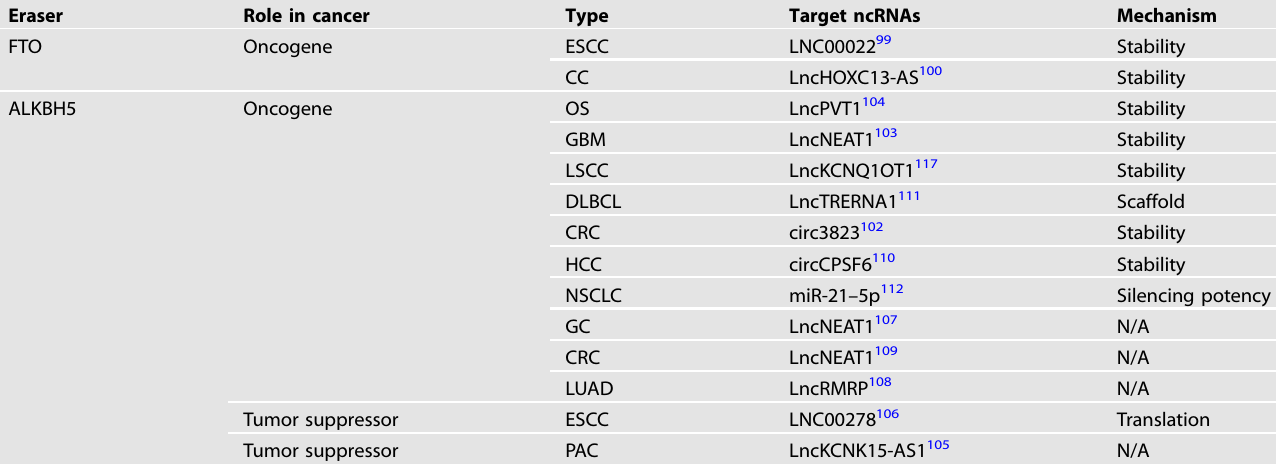
Table 2. The role of demethylases and their regulated ncRNAs in various